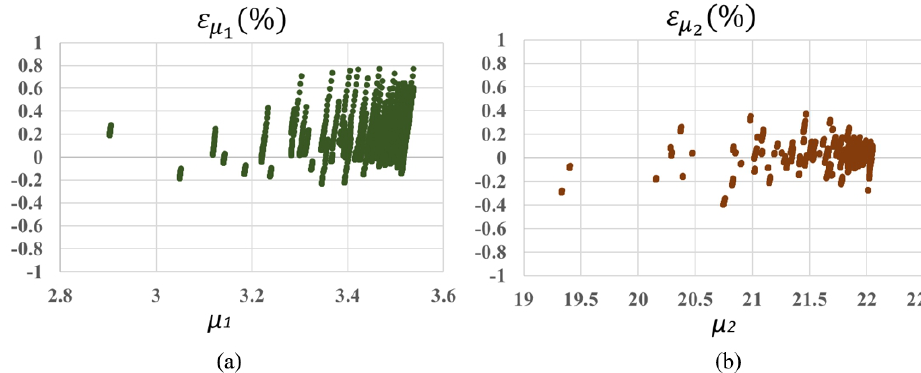
Figure 11. Percent error for µ 1 ( a ) and µ 2 ( b ).